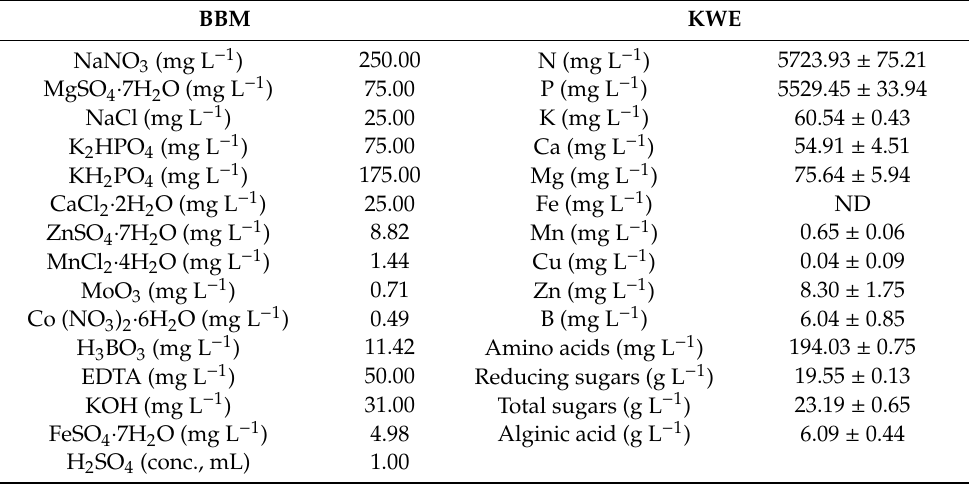
Table 2. Composition of Bold’s basal medium (BBM) and kelp waste extract